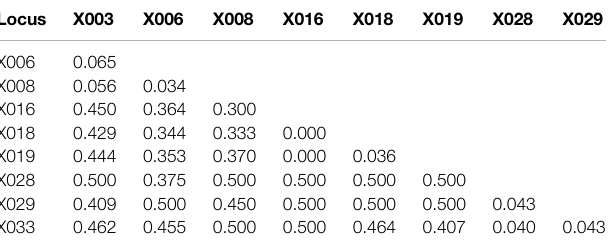
TABLE 6 | The recombination fraction for all pairs of